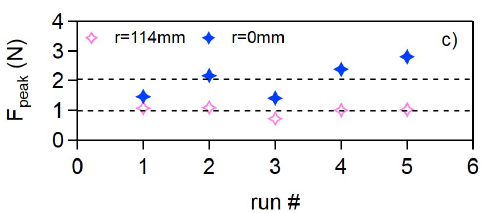
Fig. 3. Force signal at a) 𝑟 =0 and b) 𝑟 =114.0mm. c) The force peak values for both positions; the dashed lines are the averages of each set, these are 2.05±0.27 and 0.98±0.07, respectively. In the Figure 4 we show the dimensionless pressure 𝑃(𝑟)/𝑃(0) versus 𝑟/ℎ for all the experiments, with 𝑃(0) the pressure at the middle of the pile. The data seems to collapse around a well-defined curve, although with significant scattering. This collapse proposes a scaling of the type 𝑃(𝑟)/𝑃(0) ∝ 𝑓(𝑟/ℎ) , where 𝑓 is an unknown fitting function. In the same figure, we have included the fits obtained from Eqs. 1, 2, 3 and the Lorentz function (1 + (𝑟/ℎ) (cid:2870) ) (cid:2879)(cid:2869) .